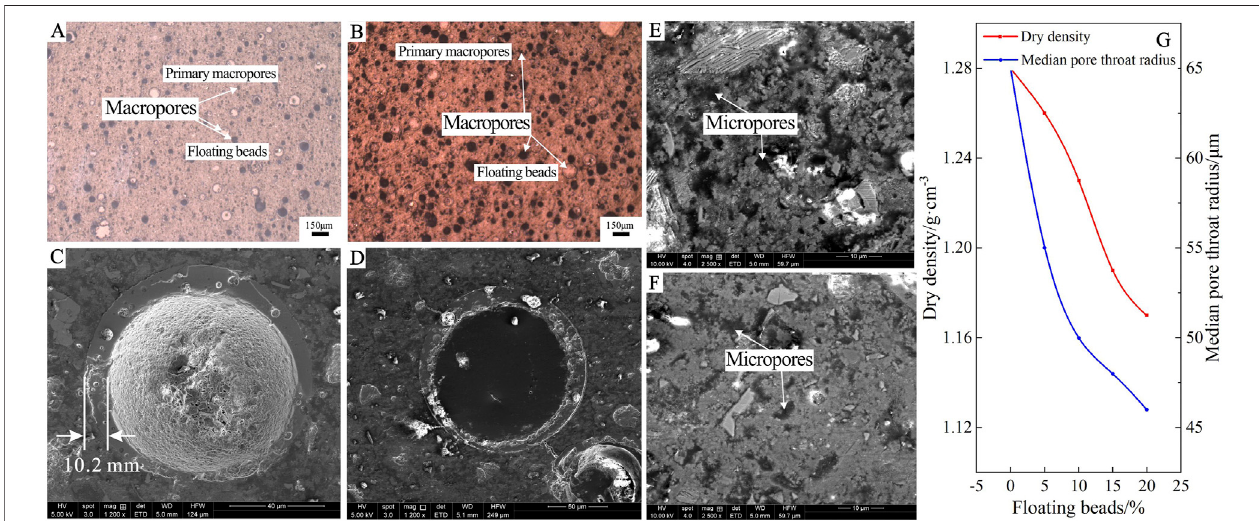
FIGURE 5 | Microstructure and related parameters of thermal insulation cement with fl oating beads. (A) Microstructure of thermal insulation cement with 10% fl oating beads under the microscope. (B) Microstructure of thermal insulation cement with 20% fl oating beads under the microscope. (C, D) Microstructure of fl oating beadsunderSEM. (E) Microstructureofthermalinsulationcementwith10% fl oatingbeadsunderSEM. (F) Microstructureofthermalinsulationcementwith20% fl oating beads under SEM. (G) Dry density and median pore throat radius of thermal insulation cement with fl oating beads.